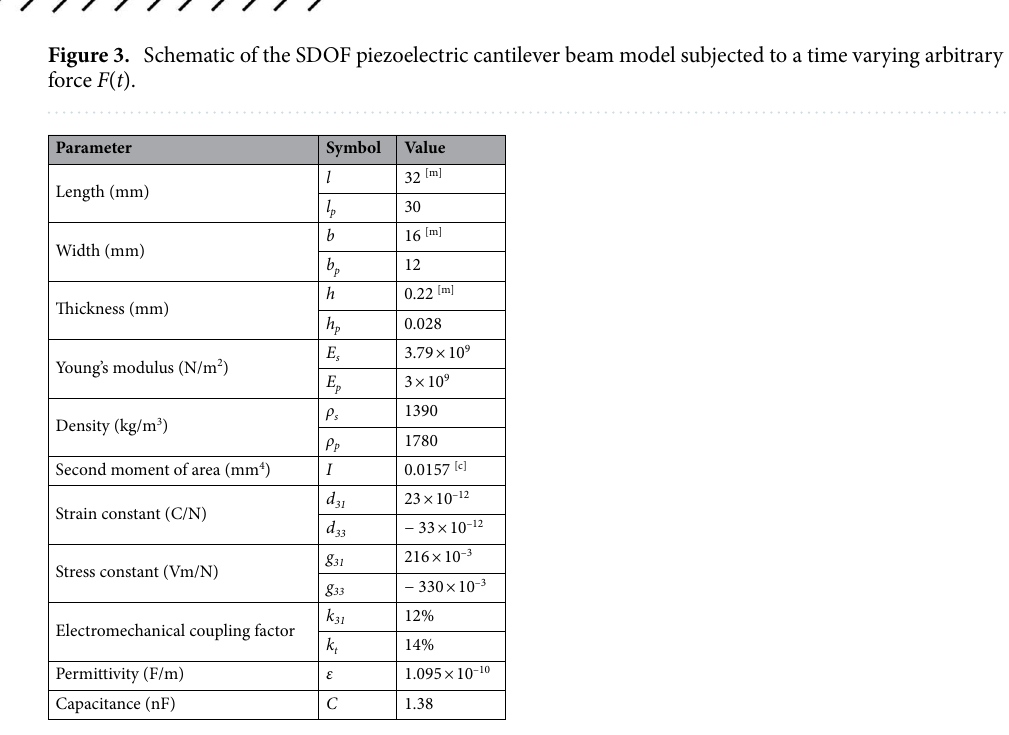
Table 2. Dimensions and properties of piezoelectric thin-film 8,16,22 . Subscript p represents PVDF film element and subscript s the Mylar substrate. Superscript [c] indicates calculated and [m] experimentally measured